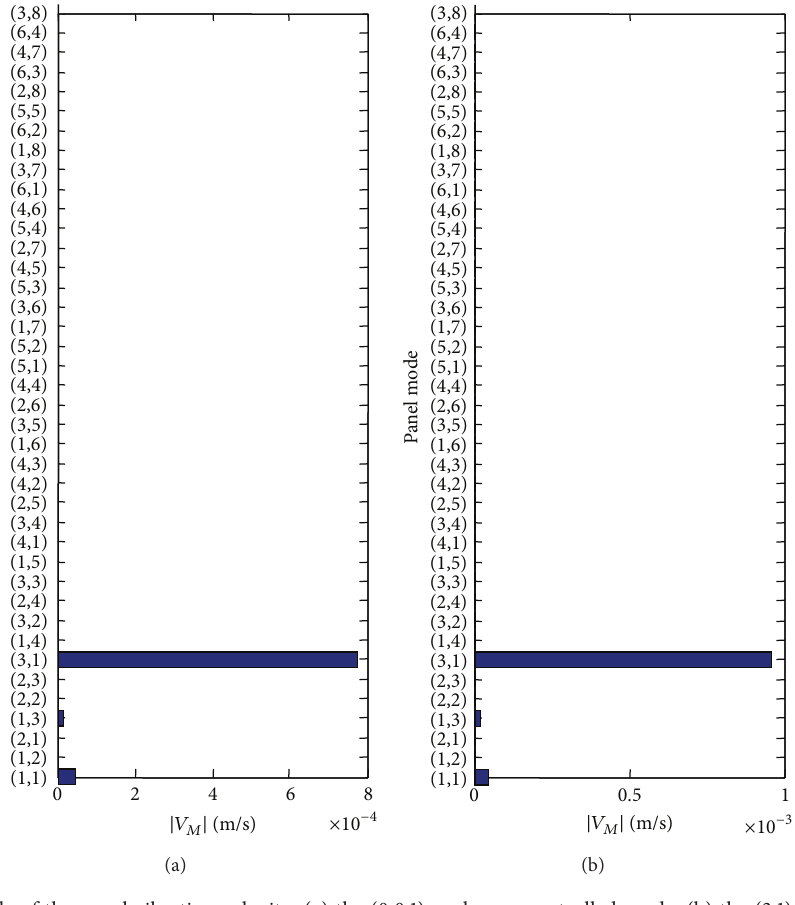
be excluded, and truncation errors exist in the calculation of resonance frequencies and decay times of acoustical